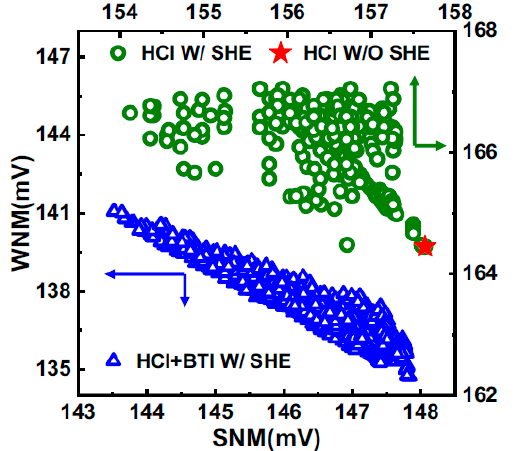
Figure 43. Simulated read static noise margin (SNM) vs. write noise margin (WNM) of the Static Random Acess Memory (SRAM) cell considering HCI degradation and HCI together with BTI degradation after 10 8 s operating time [304].